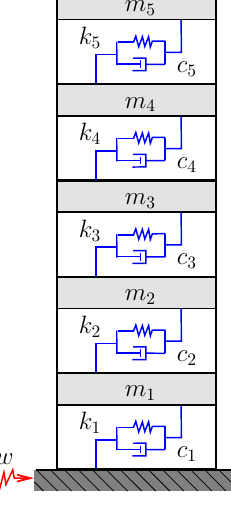
Figure 5: Five-story building